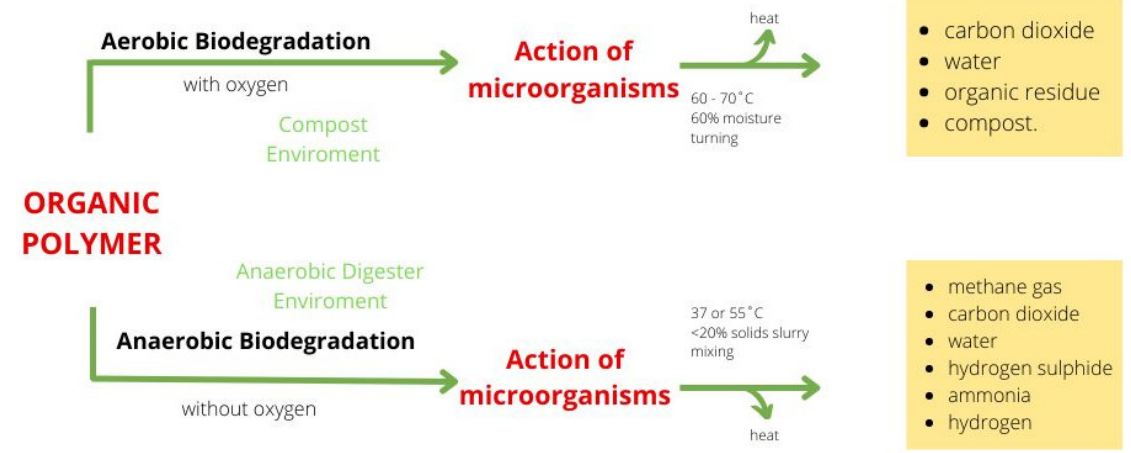
Figure 1. Aerobic and anaerobic degradation pathways for organic polymers [30].